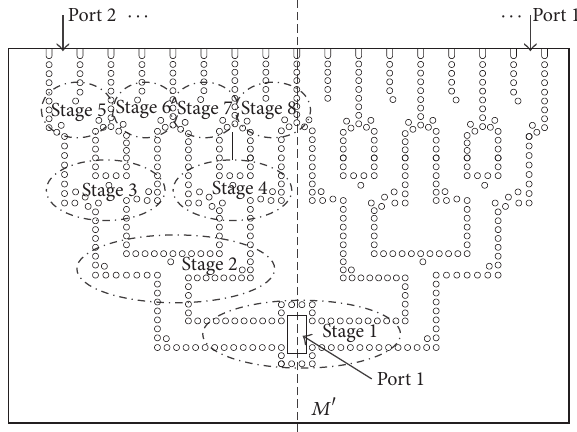
Figure 6: Configuration of the sixteen-way unequal feeding